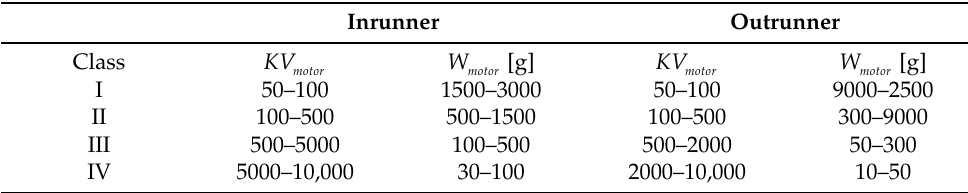
Table 3. Range of motor weight ( W motor [g]) as function of the voltage constant KV motor (based on Figure